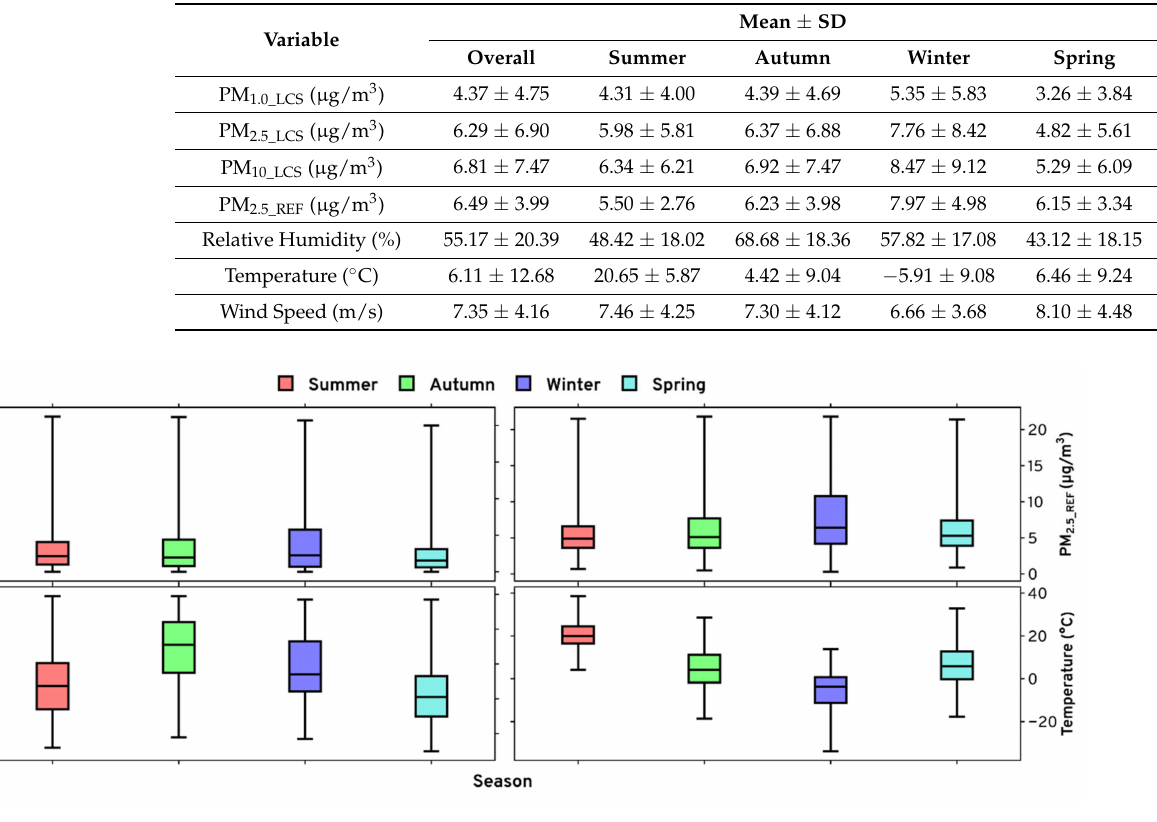
Figure 1. Boxplot of variables for each season.